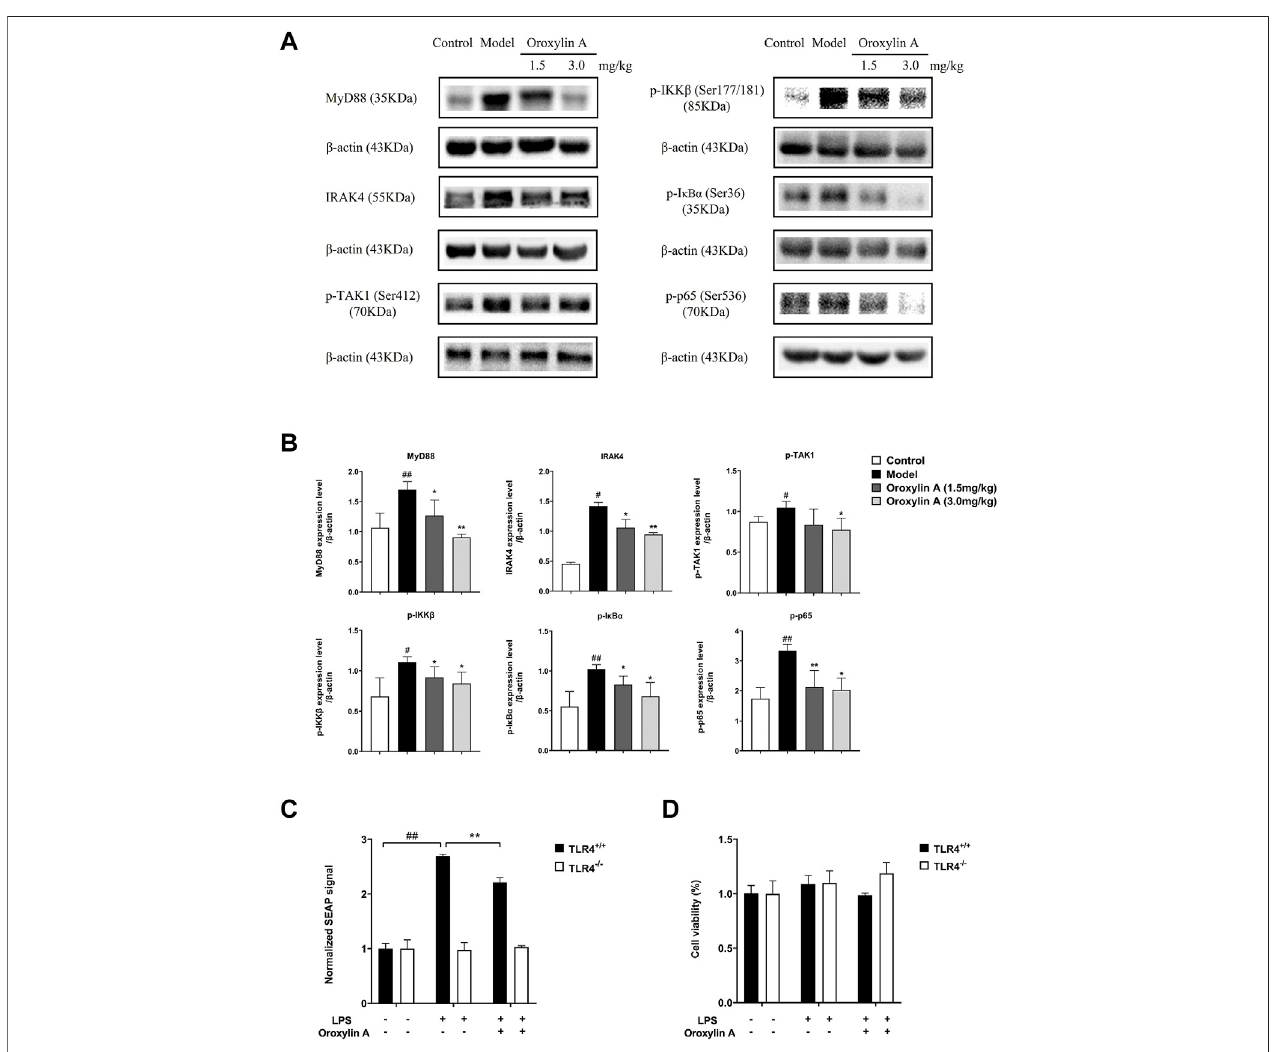
FIGURE7| OroxylinAsuppressed theactivationofTLR4/NF- κ Bsignalingpathways invitro and invivo . (A) Related proteinsoftheTLR4-NF κ Bpathway evaluated by Western blot assay. (B) Statistical results of the protein levels of MyD88, IRAK4, p-TAK1, p-IKK β , p-I κ B α , and p-p65. The band intensity was normalized by β -actin and calculated according tothe gray level. (C) Activities oforoxylin A(50 µM) in HEK-Blue hTLR4 cells and HEK-Blue null cells evaluated by measuring the expression of SEAP signal-induced by LPS (1 µg/ml). (D) Cell viability of HEK-Blue hTLR4 cells and HEK-Blue null cells with different treatment of LPS (1 µg/ml) or oroxylin A (50 µM)byMTTassay.Thesampleswere n =3pergroup.Dataarepresentedasmean±SD.# p < 0.05vs.control,## p < 0.01vs.control,* p < 0.05vs.model,** p < 0.01 vs.